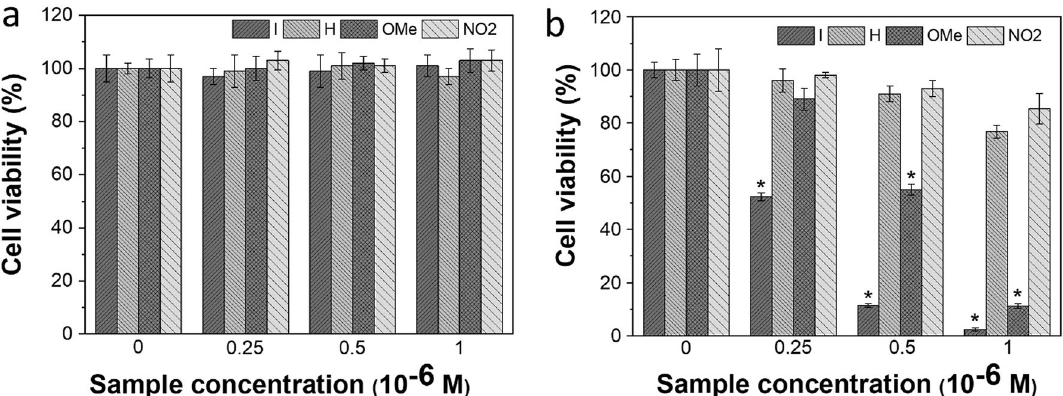
Figure 7. Photodynamic anticancer activities of BODIPY PSs in Huh-7 cells. Cytotoxicity ( a ) and phototoxicity ( b ) of BODIPY I, H, OMe, and NO2-NPs in Huh-7 cells (hepatocellular carcinoma) under light irradiation (λ irr 530 nm, 8.6 J·cm -2 ). The cell viabilities were detected using a CCK-8 kit after incubation with I, H, OMe, and NO2-NPs for 24 h under dark conditions. Quantitative data are expressed as mean ± standard deviation (n = 4). Statistical significance based on the Student’s t -tests was considered as * p <